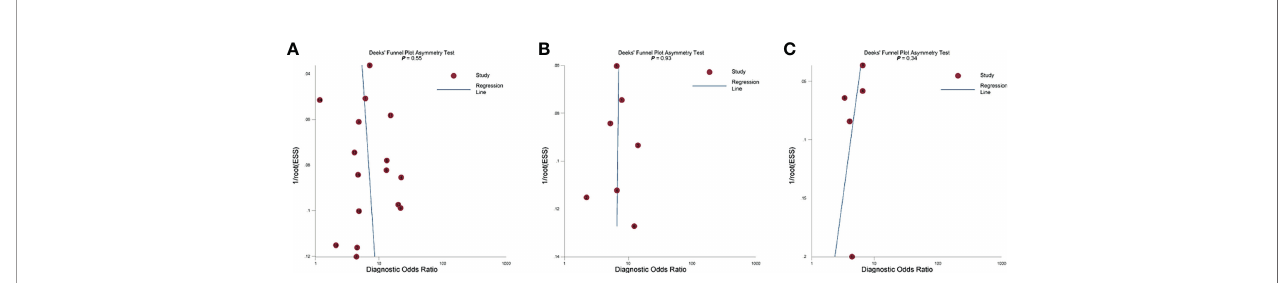
FIGURE 5 | The Deeks ’ funnel plot. (A) Length of capsular contact; (B) apparent diffusion coef fi cient; (C)